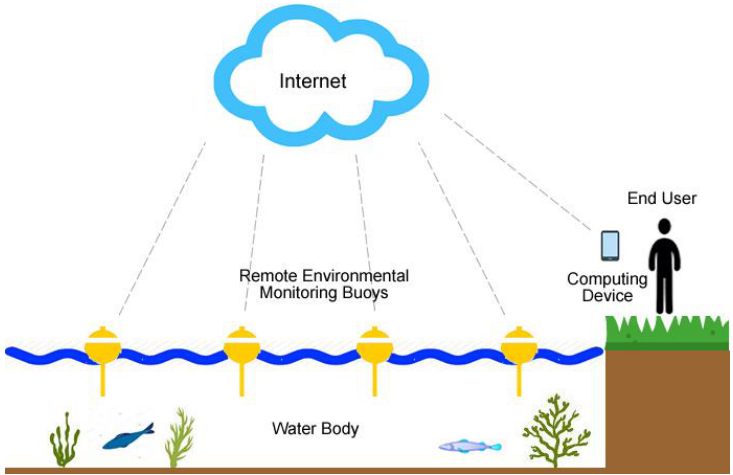
Figure 1. The Smart Environmental Monitoring and Assessment Technologies (SEMAT) Aquatic Sensor Network Architecture including data access via mobile devices.